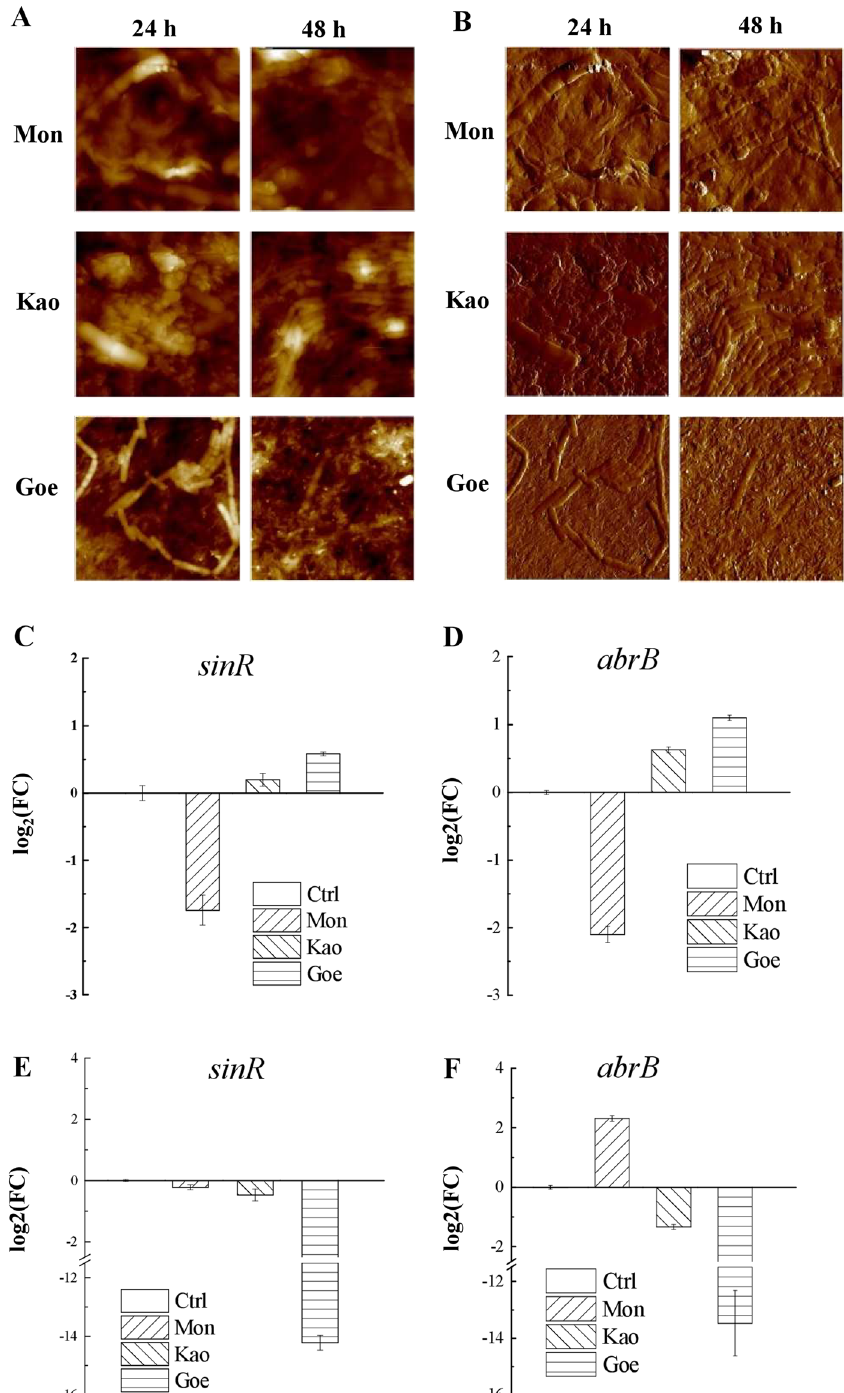
Fig. 4 Contact of minerals and bacteria cells, and the resulting gene experssion changes. AFM height ( a ) and peak force images ( b ) of B. subtilis bio fi lm formed on mineral surfaces after 24 and 48 h (20 × 20 μ m 2 ). Top panel : B. subtilis on montmorillonite-coated surface (Mon); Middle panel : B. subtilis on kaolinite-coated surface (Kao); Bottom panel : B. subtilis on goethite-coated surface (Goe). c – f : Quantitative expression analyses of the sinR ( c , e for 24, 48 h, respectively) and abrB ( d , f for 24, 48 h, respectively) genes. Both of the genes are critical regulators that involved in the regulation of B. subtilis bio fi lm formation and cell